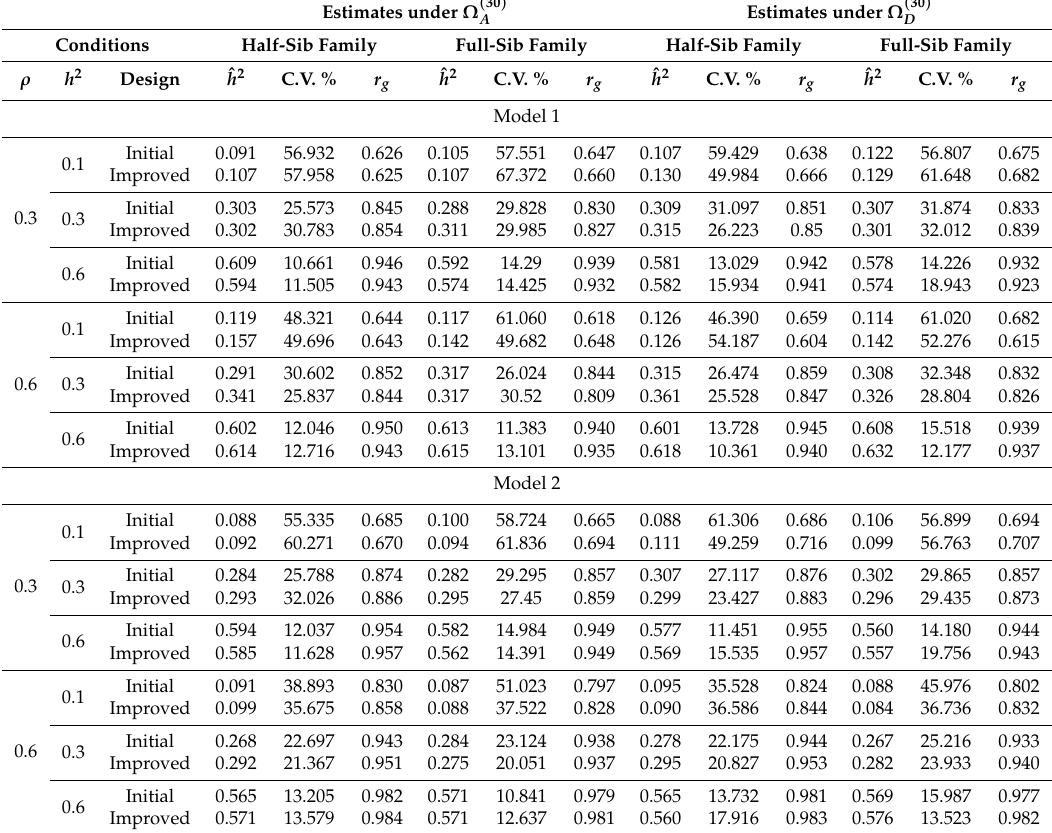
( 196 ) scenario. Each condition A